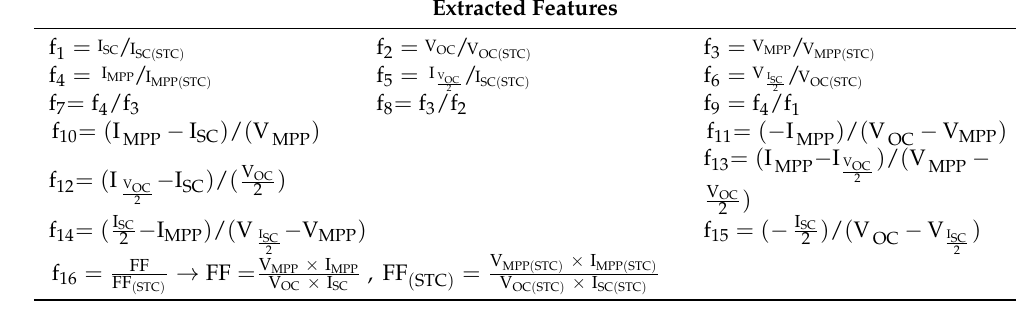
Extracted Features